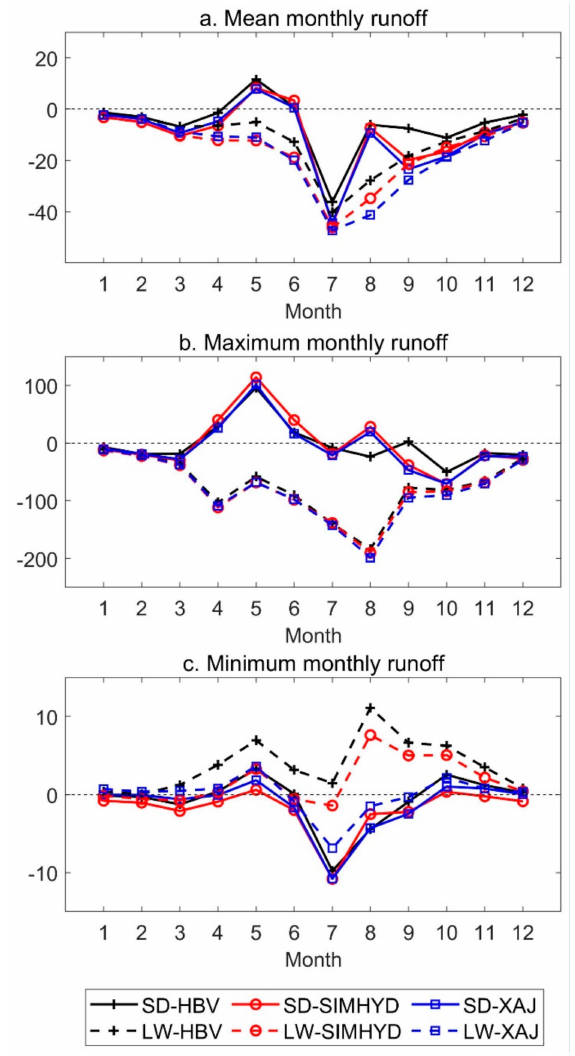
Figure 5. Changes in mean monthly runoff ( a ), maximum monthly runoff ( b ) and minimum monthly runoff ( c ) (unit: 10 8 m 3 /month) from the baseline period to the future period projected with different model